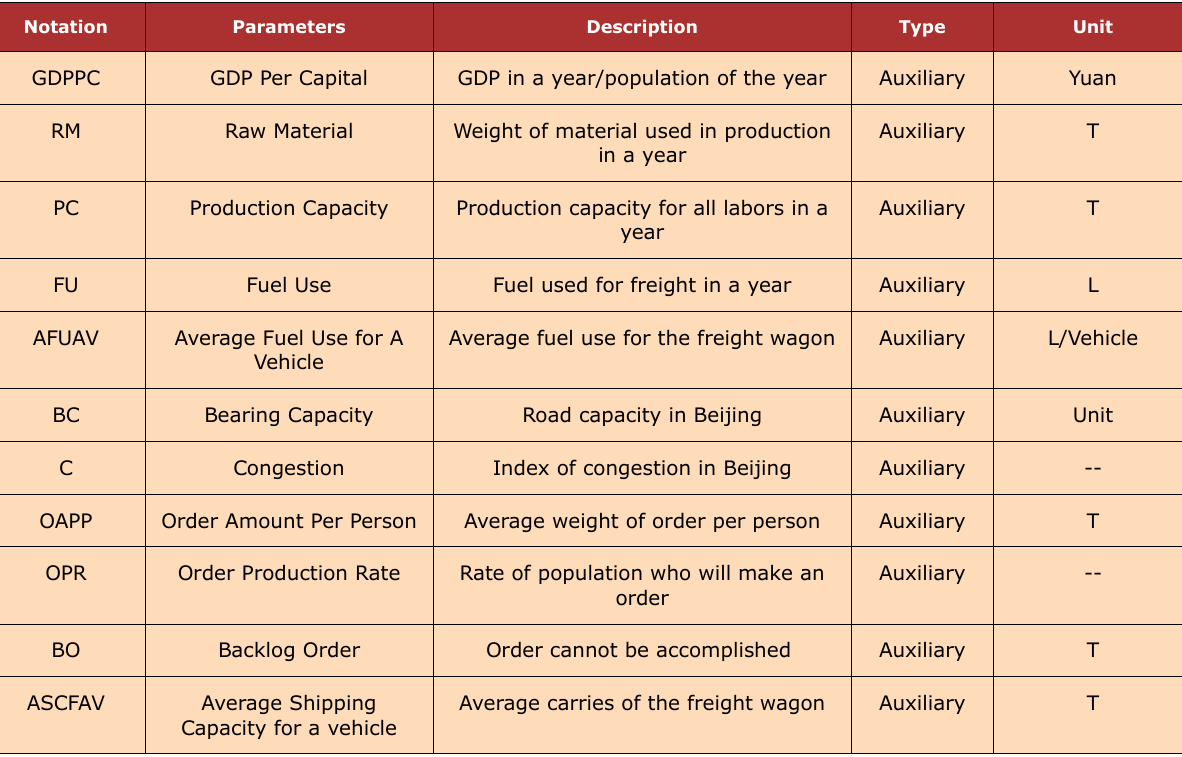
Table 2. Parameters list of SD